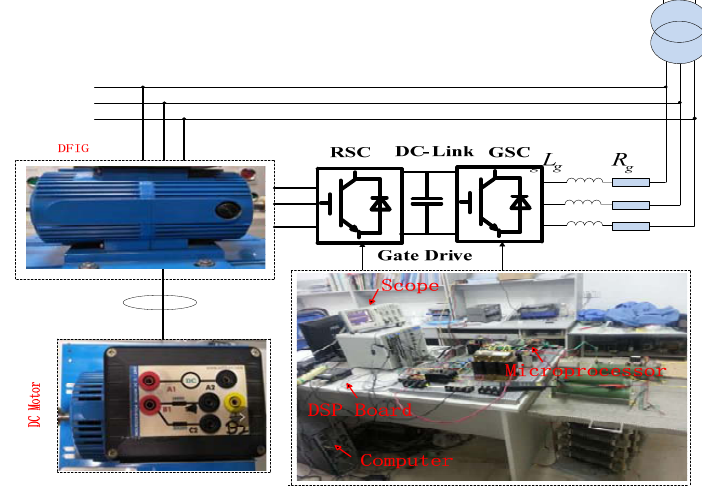
Figure 13. Experimental test bed.